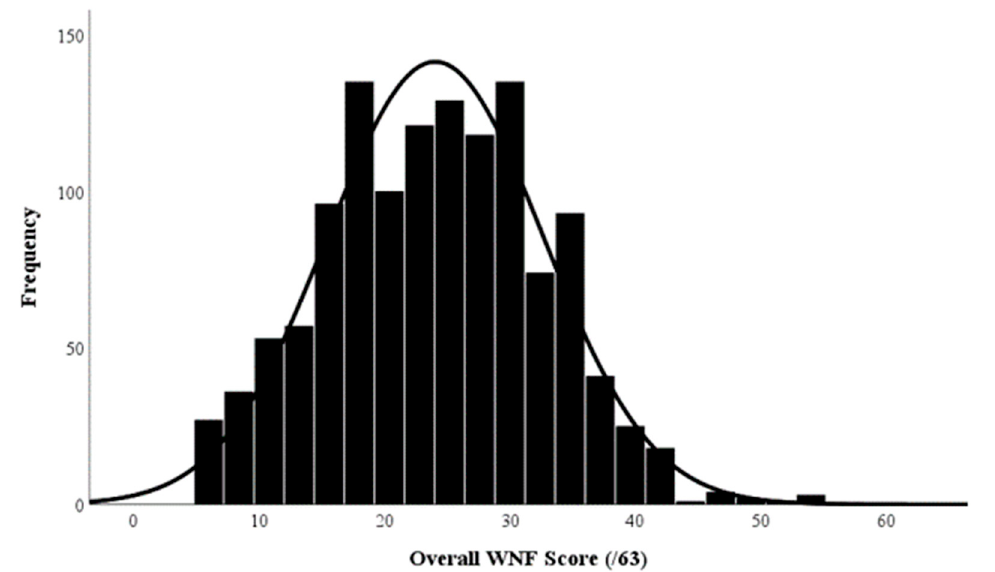
Figure A2. Distribution of the modified Wine Neophobia Scale (mWNS) scores (N = 1269).